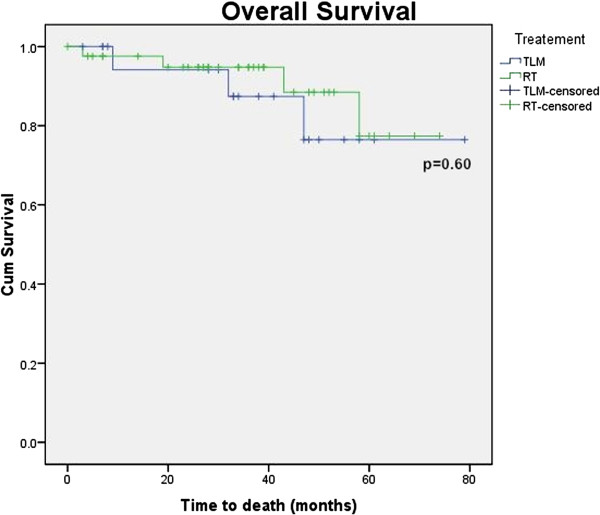
Overall survival.